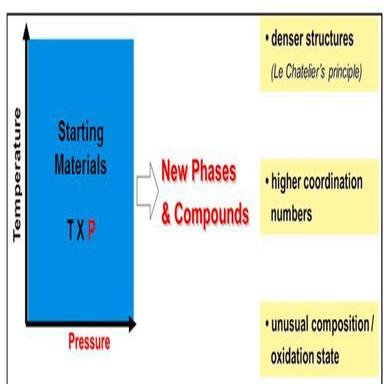
Pressure as additional reaction parameter to synthesize materials with denser structures, higher number of coordination and unusual compositions.